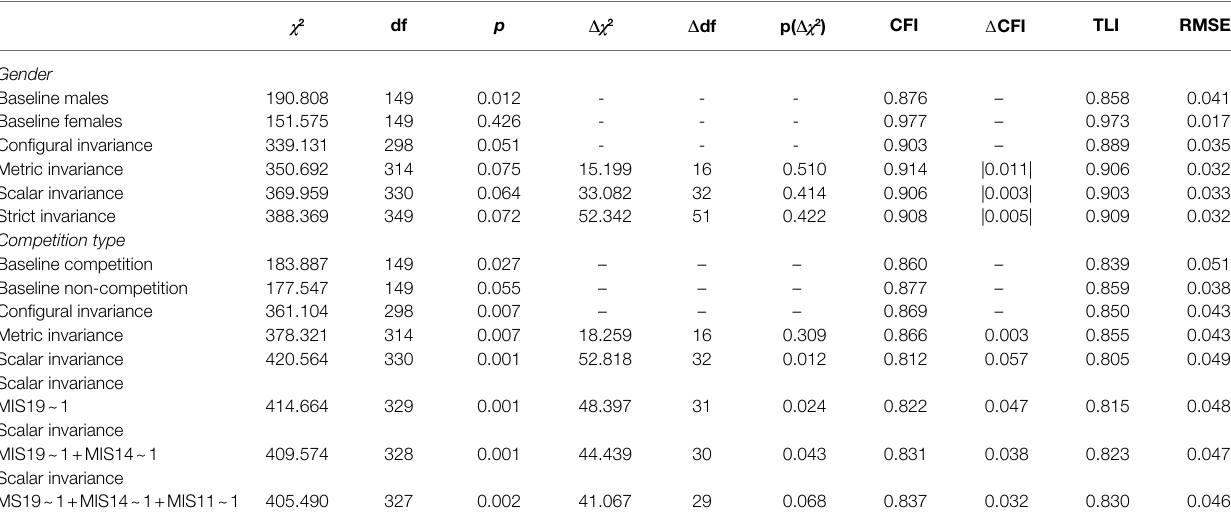
TABLE 2 | Results of multi-group comparing within MIS-D (German